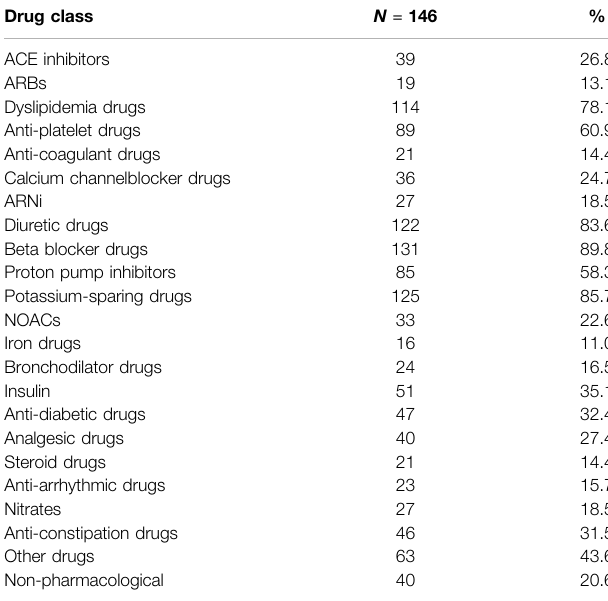
TABLE 5 | Cardiac pro fi ling. Characteristic Diastolic dysfunction